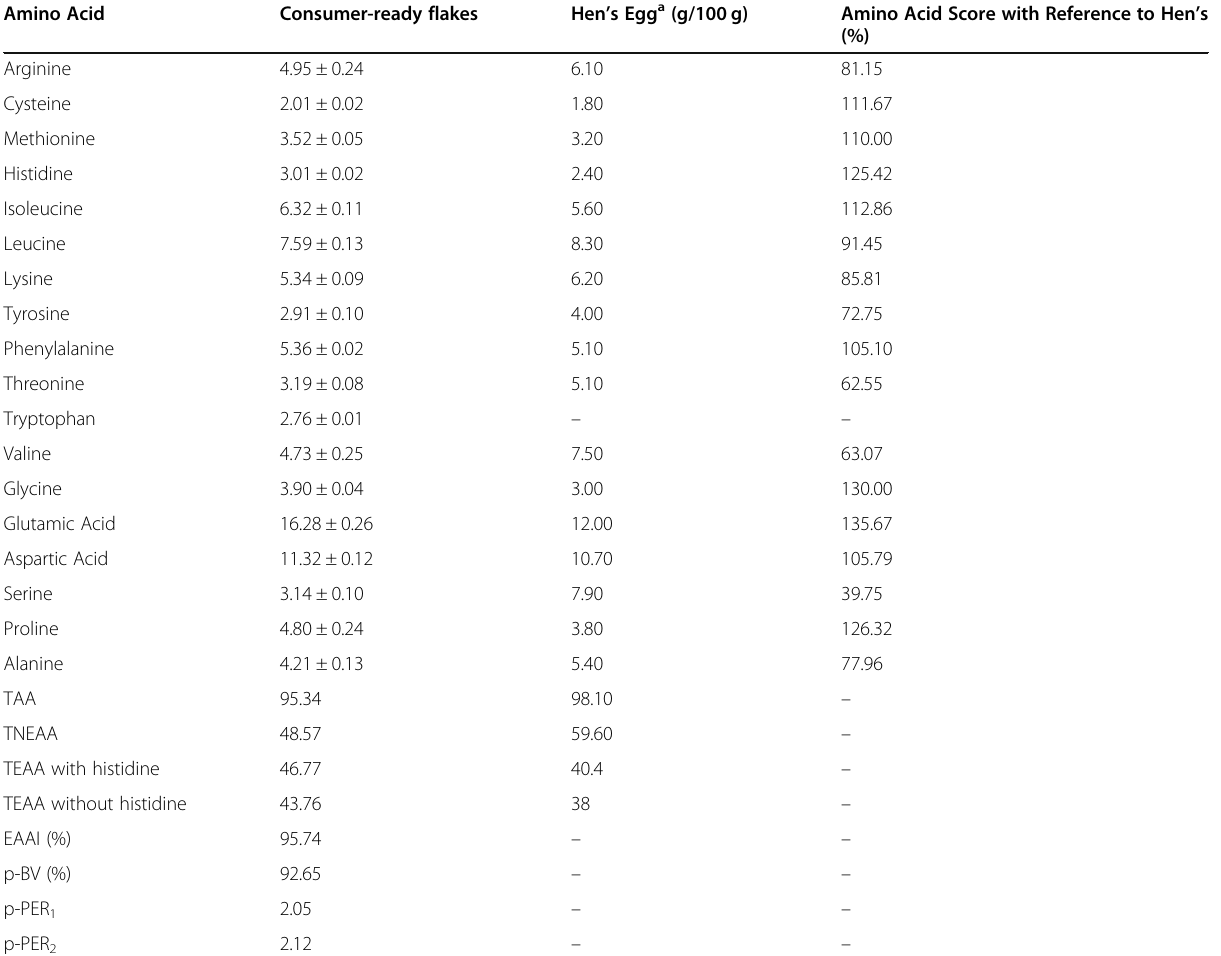
Table 6 Amino acids profile of consumer-ready flakes from high-protein soymeal, amaranth and modified corn starch produced under optimal condition Amino